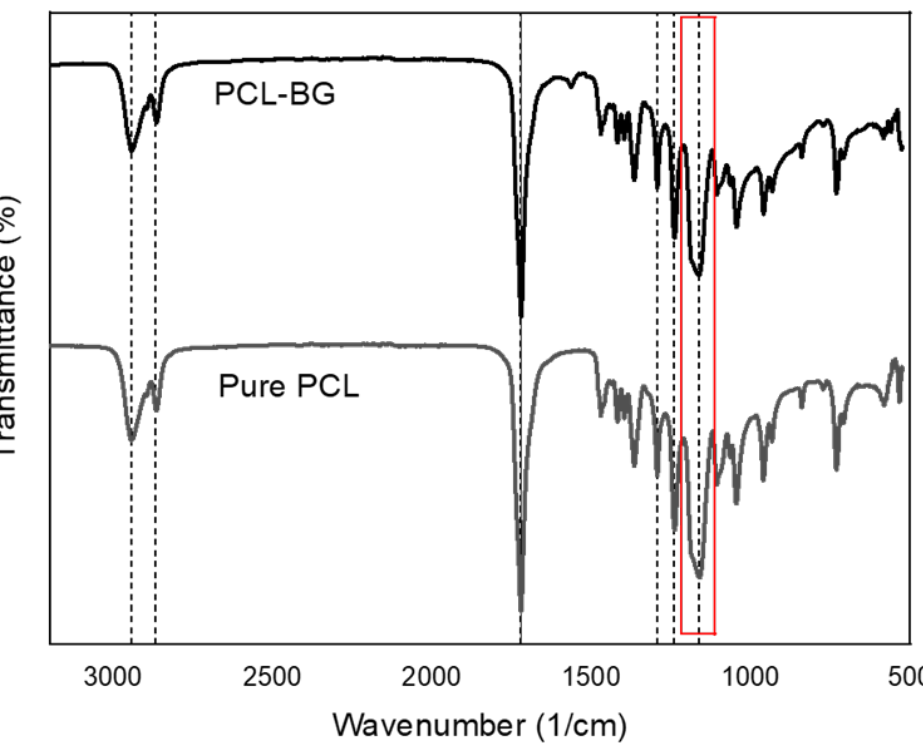
Figure 9. The FTIR spectra of the PCL and PCL – bioglass scaffolds.